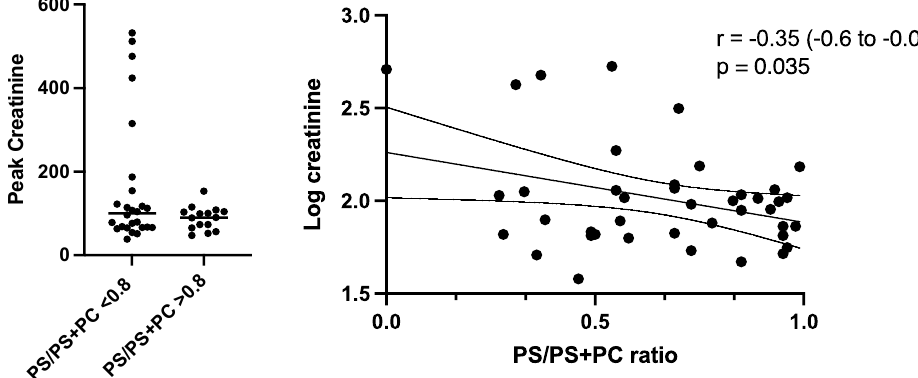
Figure 1. First panel shows the peak creatinine levels in µmol/L during the ICU stay in patients with a ratio (PS/PC + PS) above 80% and below 80%. A trend is seen but is not statistically significant ( p = 0.072). In the second panel a significant negative correlation (r = − 0.35) is seen between peak creatinine levels and the predominance of controlled ventilation.